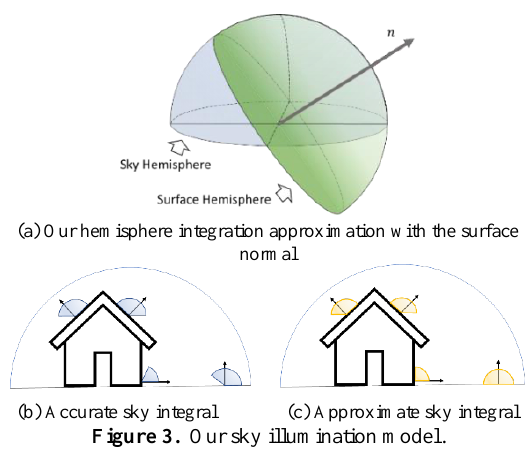
Figure 5. Geometric features projection to